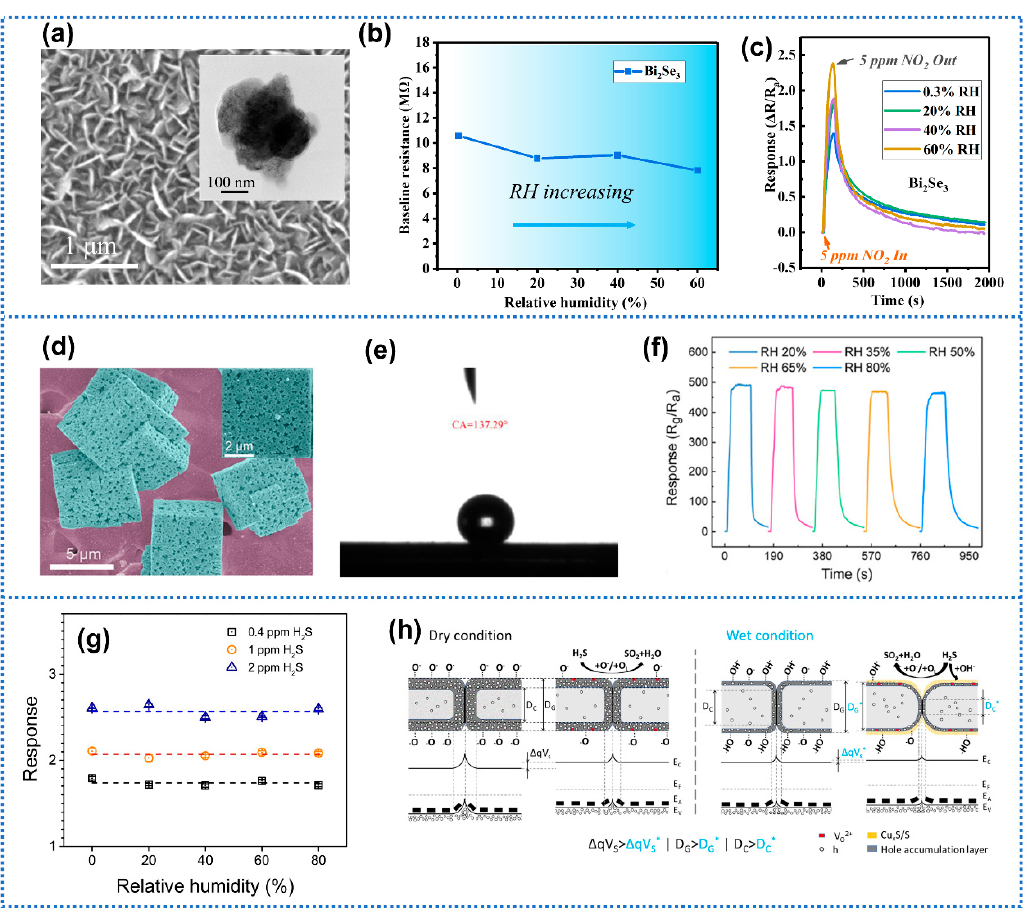
Figure 11. ( a ) SEM image of free − standing Bi 2 Se 3 nanoplates, inset: TEM image of single Bi 2 Se 3 nanoplate. ( b ) Baseline resistance of Bi 2 Se 3 sensors at different humidity conditions. ( c ) Dynamic gas-sensing transients of the Bi 2 Se 3 sensor to 5 ppm NO 2 at different humidity conditions. Reprinted with permission from Ref. [50]. Copyright 2022, Elsevier. ( d ) SEM image of the porous In 2 O 3 sample. ( e ) Water contact angle of the porous In 2 O 3 sample. ( f ) Dynamic gas-sensing transients of the In 2 O 3 sensor to 50 ppm NO 2 as a function of RH at room temperature. Reprinted with permission from Ref. [51]. Copyright 2021, American Chemical Society. ( g ) Sensor responses toward different H 2 S concentrations as a function of relative humidity. ( h ) Schematic of the CuO nanosheet sensing layer from the aspects of morphology, energy band, and surface reactions under dry and humid condi- tions. Reprinted with permission from Ref. [130]. Copyright 2020, Elsevier.